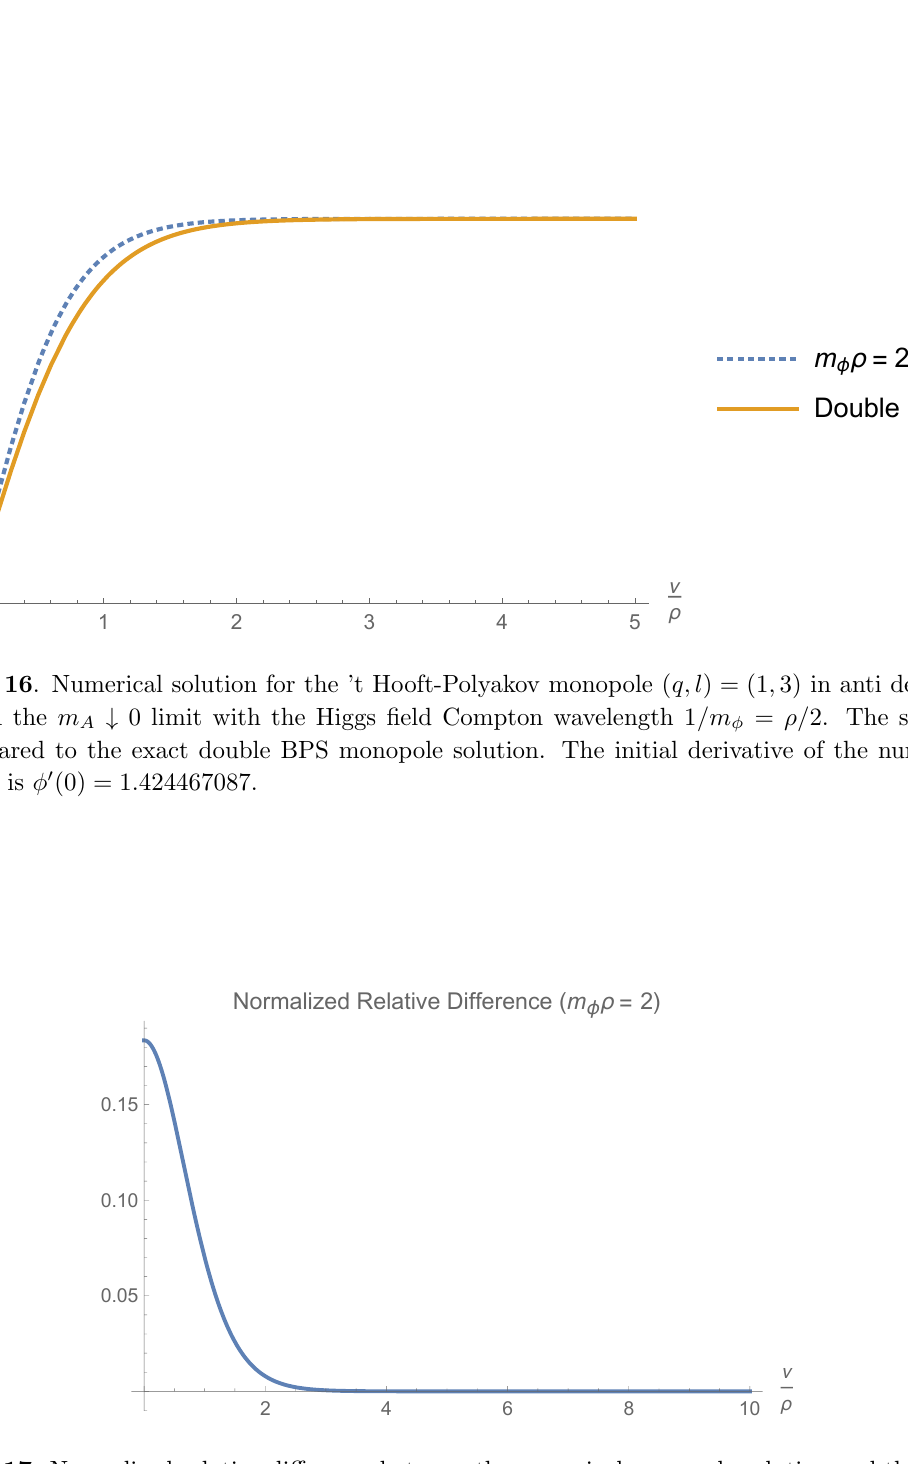
, where (cid:30) dBPS 1 2 ( (cid:30) ( (cid:23) )+ (cid:30) dBPS ( (cid:23) ))